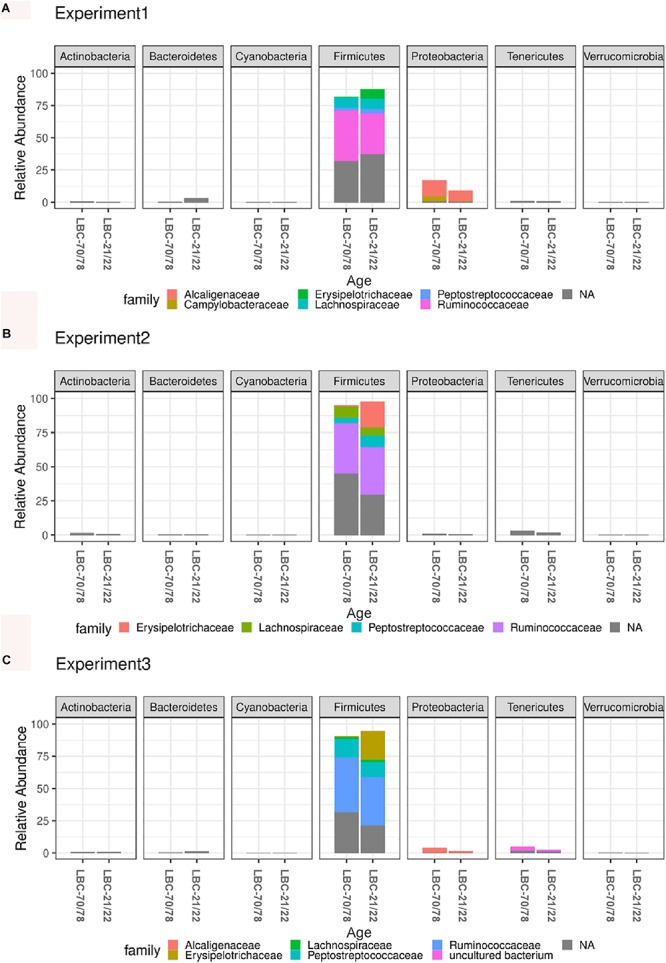
Microbiota composition analysis using 16S rRNA sequencing in caecal contents of different aged chickens at time of infection. Relative abundance of the 11 most abundant OTUs belonging to bacterial families within different phyla in experiment 1 (A). Relative abundance of the 11 most abundant OTUs belonging to bacterial families within different phyla in experiment 2 (B). Relative abundance of the 11 most abundant OTUs belonging to bacterial families within different phyla in experiment 3 (C). LBC-21/22, Lohmann Brown-Classic, infection at the age of 21/22 days; LBC-70/78, Lohmann Brown-Classic, infection at the age of 70/78 days; NA, OTUs without genus-level taxonomic assignment.